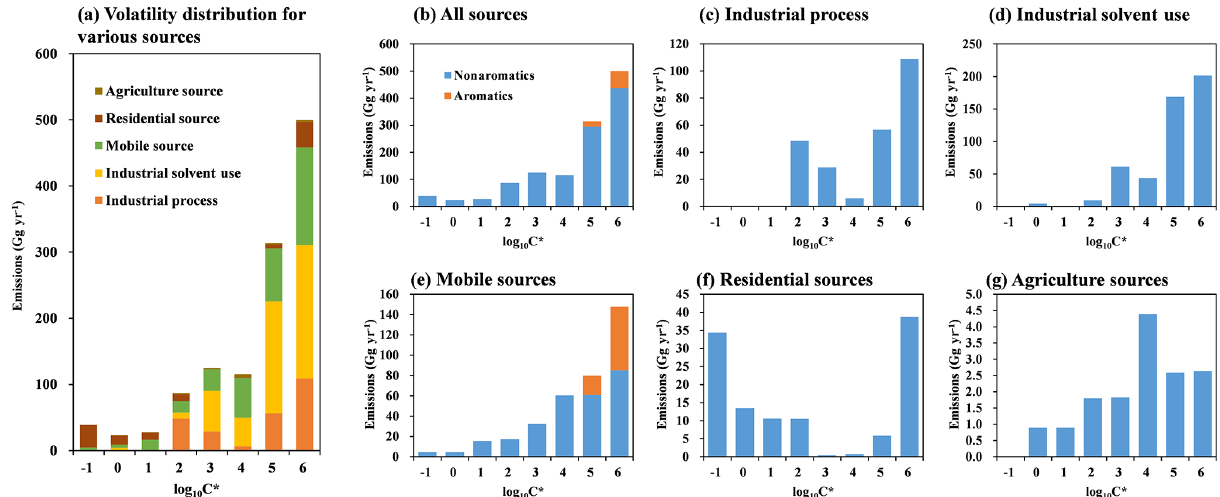
Figure 2. Volatility distributions of I/SVOCs emitted from different sources in the YRD